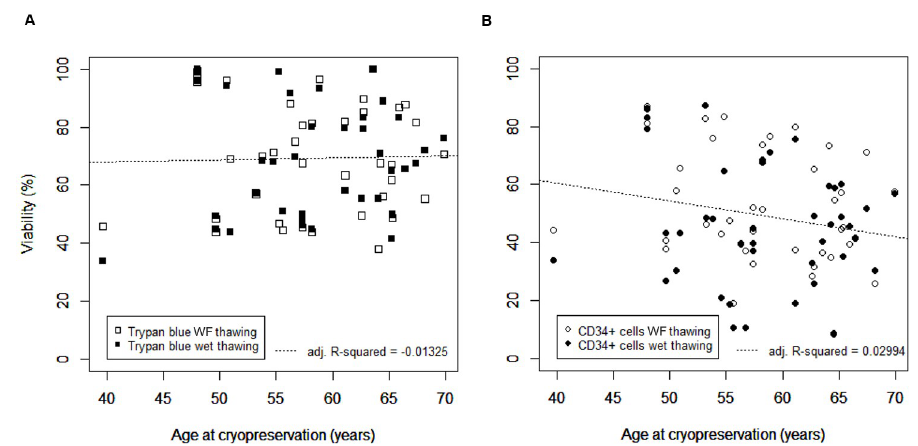
Fig 4. The effect of patient age at initial collection of leukapheresis samples before cryopreservation on immediate post-thaw cell viability. (A) Immediate post-thaw cell viability determined as trypan blue exclusion or (B) by flow cytometry for CD34+ cells. Results for water-free and wet thawing are presented as open and filled symbols, respectively. Linear models applied to the combined water-free (WF) and wet thawing datasets as a function of patient age are shown as dashed lines, and the adjusted square of their Pearson correlation coefficient (adj. R-squared) indicating the percentage of variability in the dataset explained by the linear model, is indicated.